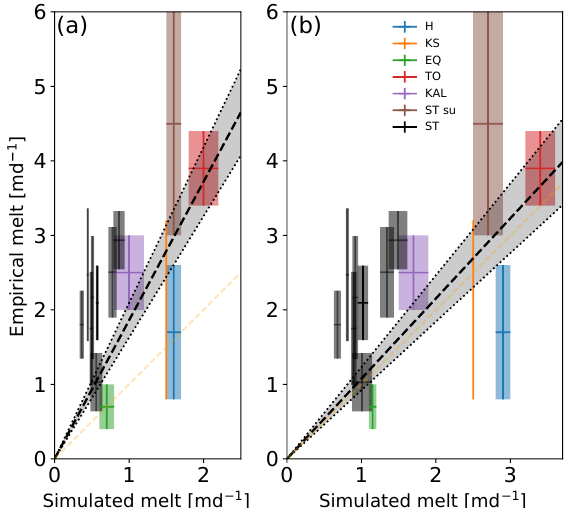
Figure 16. Measured versus simulated melt rate for a number of glaciers, for data given in Table 6. The squares represent error bars in measured and simulated melt rate. The black regression line with 1-sigma uncertainty range indicates the average scaling co- efficient of 1 . 85 required to match observations given model pa- rameters. In both panels, entrainment rate is 0.036. Panel (a) shows model simulations with default values for the heat transfer coef- ficient (cid:48) T = 2 . 2 × 10 − 2 , while panel (b) shows simulation with (cid:48) T = 4 . 2 × 10 − 2 , which produces a scaling coefficient closer to one. Glacier abbreviations are shown in Table 6. Note that only one rep- resentative value for the Store Glacier in winter was used, as re- ported in Table